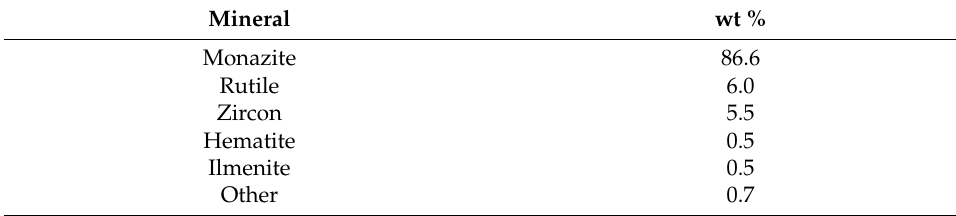
Figure 5. XRD diffractogram of monazite concentrate. Table 7. Mineralogical composition of monazite concentrate from MS 0.5A.